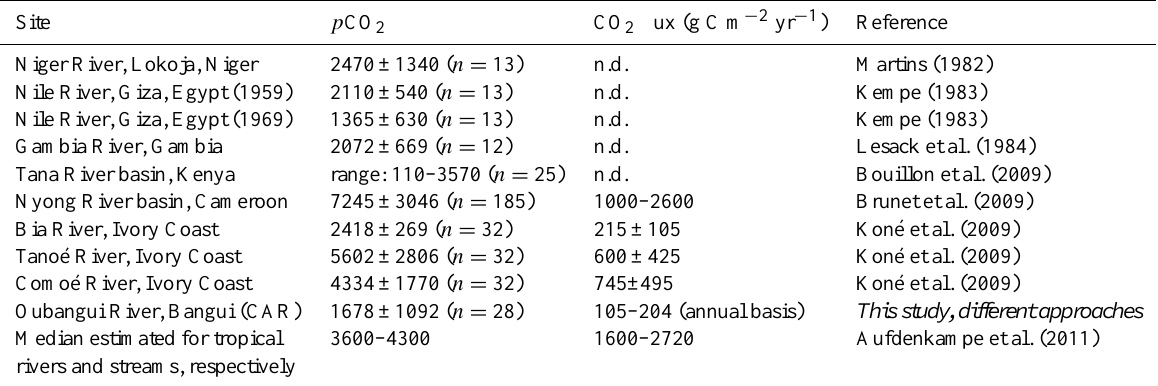
Table 2. Summary of published p CO 2 and CO 2 flux data from river systems on the African continent, and comparison with median values reported for tropical rivers and streams. Anomalously high values for the Niger River from Camail et al. (1987) are excluded as these are considered erroneous (see Cole and Caraco, 2001), and data from Mengong Spring also not included (Brunet et al., 2009). Range of CO 2 fluxes given for the Nyong River basin are annual averages for different sites (see Brunet et al., 2009). p CO 2 and CO 2 fluxes in Ivory Coast (Kon´e et al., 2009) are annual averages based on 4 seasonal surveys of 8 stations per